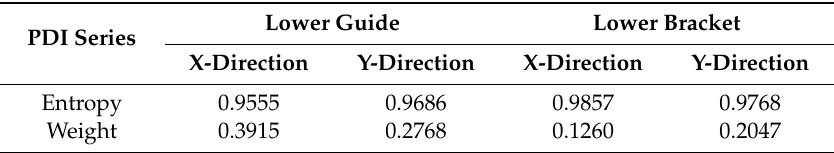
Table 3. The entropy and its weight of PDI